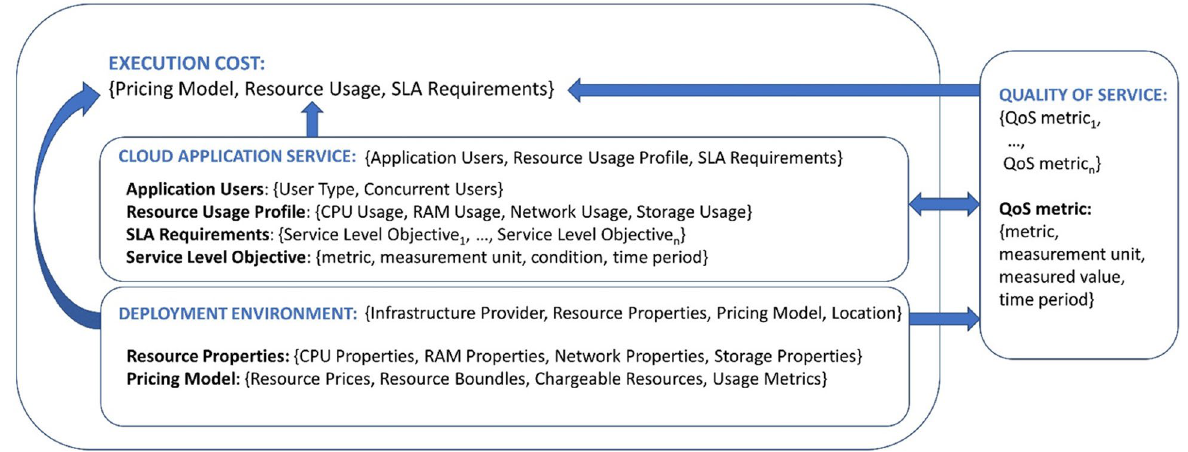
Fig. 3 Relations between cloud application context parameters, execution cost and